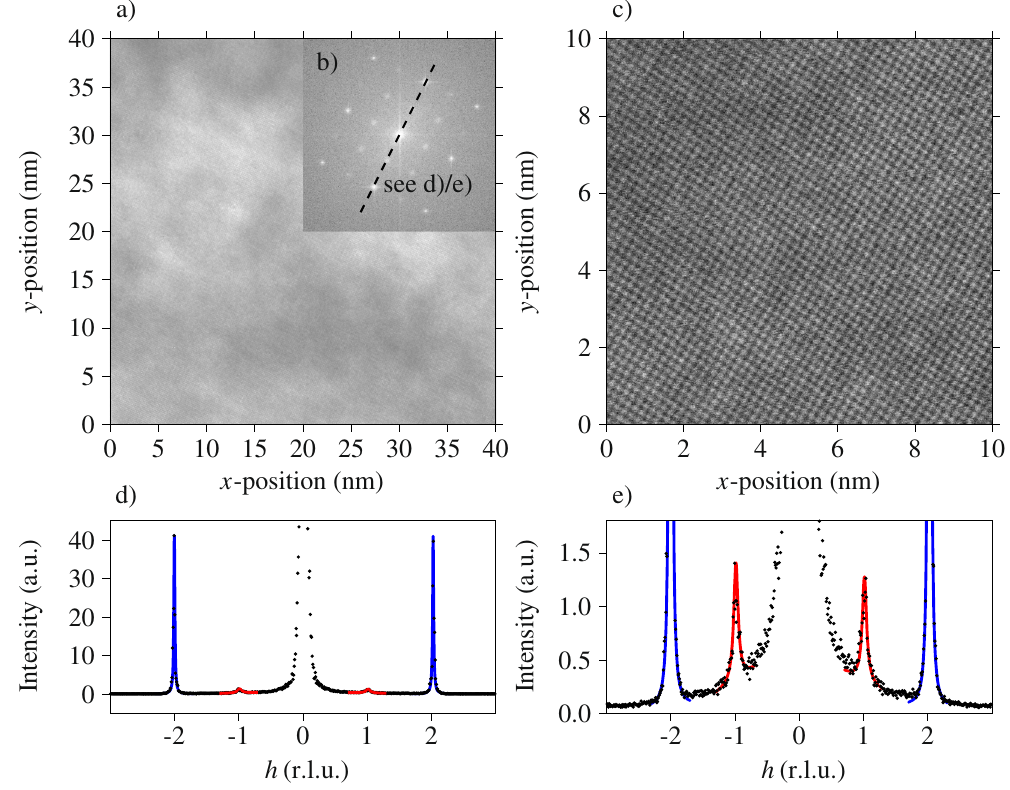
Figure 3. HRTEM image of the Al-Cu-Li alloy in the naturally aged condition ( a ) with its FFT given in ( b ) on a logarithmic scale. ( c ) shows a HAADF-STEM image of the sample. ( d , e ) give the intensity along the same line cut as indicated in ( b ) analogous to Fig. 2(c), where the y -scale in ( e ) is magnified in comparison to ( d ). In ( d , e ), the fundamental and superstructure reflections have been fitted with Lorentzian functions (blue and red lines). The HRTEM image in ( a ) has a linear gray scale with black corresponding to zero intensity. In the HAADF- STEM image ( c ) the dynamic range (black to white) corresponds to a variation in the detected intensity of 7